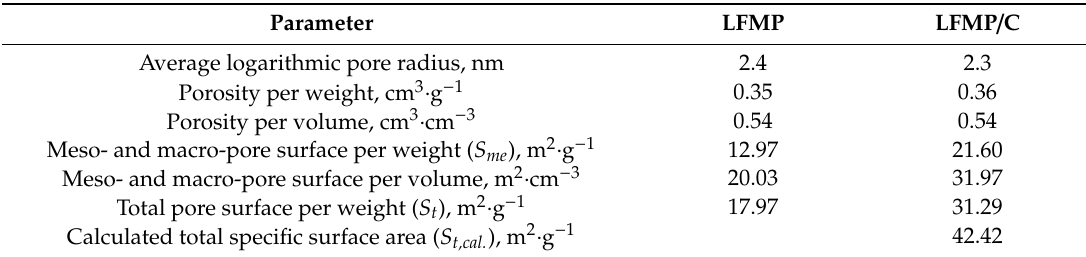
Table 1. Porosimetric data of the LFMP